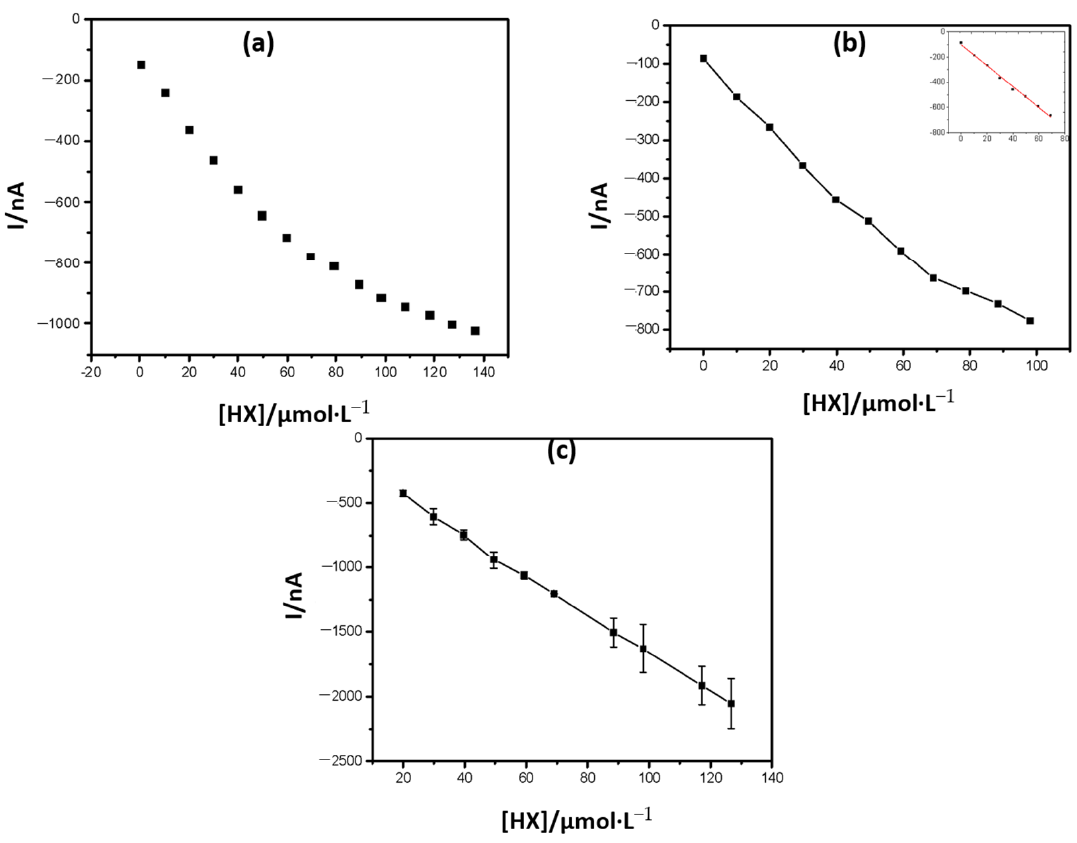
Figure 5. Curves obtained under different conditions: ( a ) 15 s of agitation, 15 s of rest, and 75 s measuring the current, fixed the time of 60 minutes of polymerization, ( b ) 30 s of agitation, 15 s of rest, and 60 s measuring the current, fixed the time of 60 minutes of polymerization, and ( c ) 15 s agitation, 15 s rest, 60 s current measurement, fixed the time of 60 minutes of polymerization.